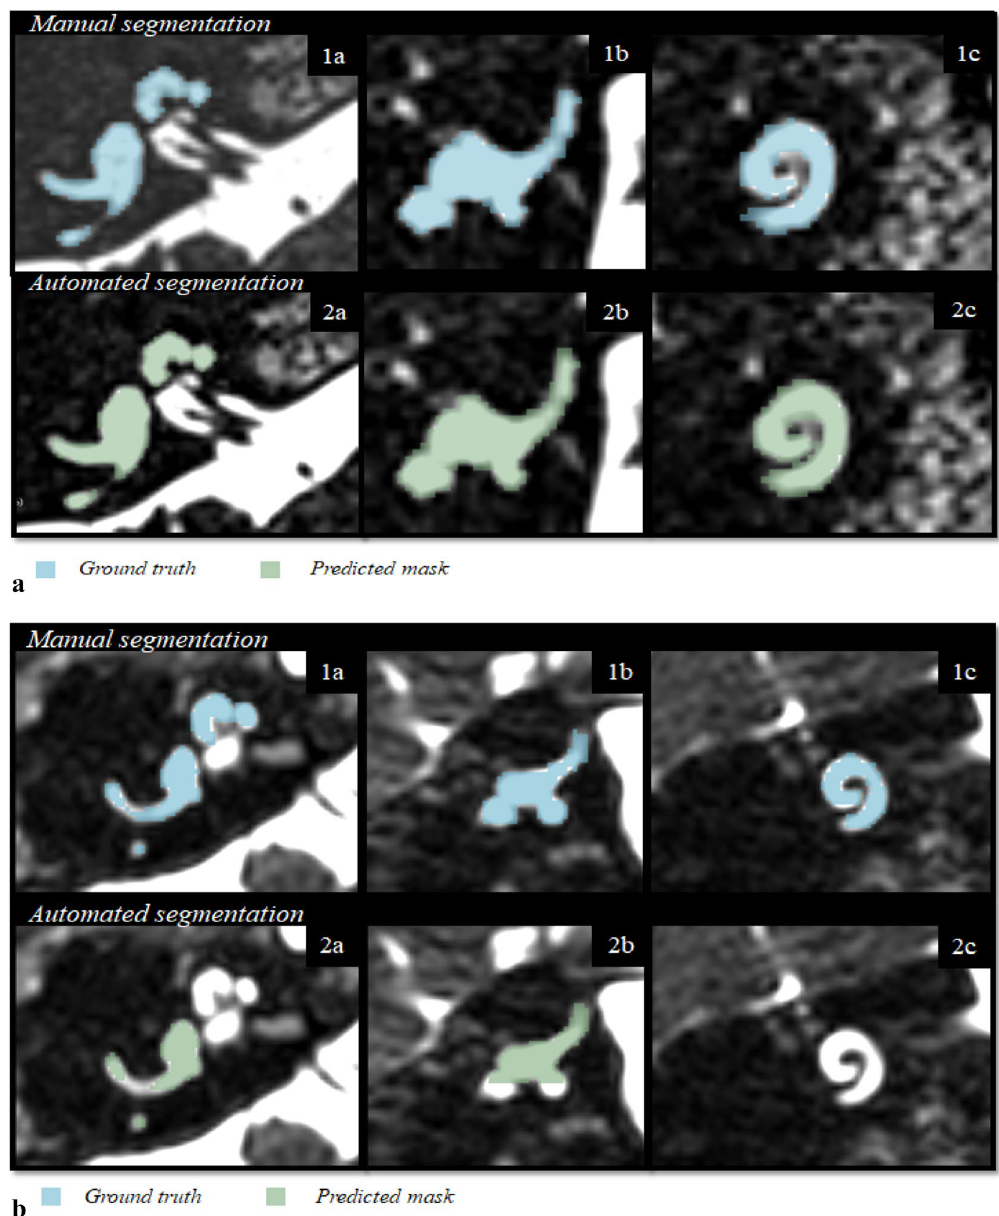
Figure 8. ( a ) Example of a well predicted segmentation. The first row denotes the ground truth segmentation. The second row contains the model’s segmentation. (1a) Ground truth, axial plane. (1b) Ground truth, sagittal plane. (2c) Ground truth, coronal plane. (2a) Predicted mask, axial plane. (2b) Predicted mask, sagittal plane. (2c) Predicted mask, coronal plane. DSC: 0.92, ground truth volume: 465.37 mm 3 , true positive volume: 445.32 mm 3 , true positive Rate: 95.69%, false negative rate: 4.3%. False discovery rate: 11.7%. ( b ) Example of a poor segmentation. The first row denotes the ground truth segmentation. The second row contains the model’s segmentation. (1a) Ground truth, axial plane. (1b) Ground truth, sagittal plane. (2c) Ground truth, coronal plane. (2a) Predicted mask, axial plane. (2b) Predicted mask, sagittal plane. (2c) Predicted mask, coronal plane. DSC: 0.48, ground truth volume: 406.05 mm 3 , true positive volume: 137.96 mm 3 , true positive rate: 33.97%, false negative rate: 66.02%. False discovery rate: